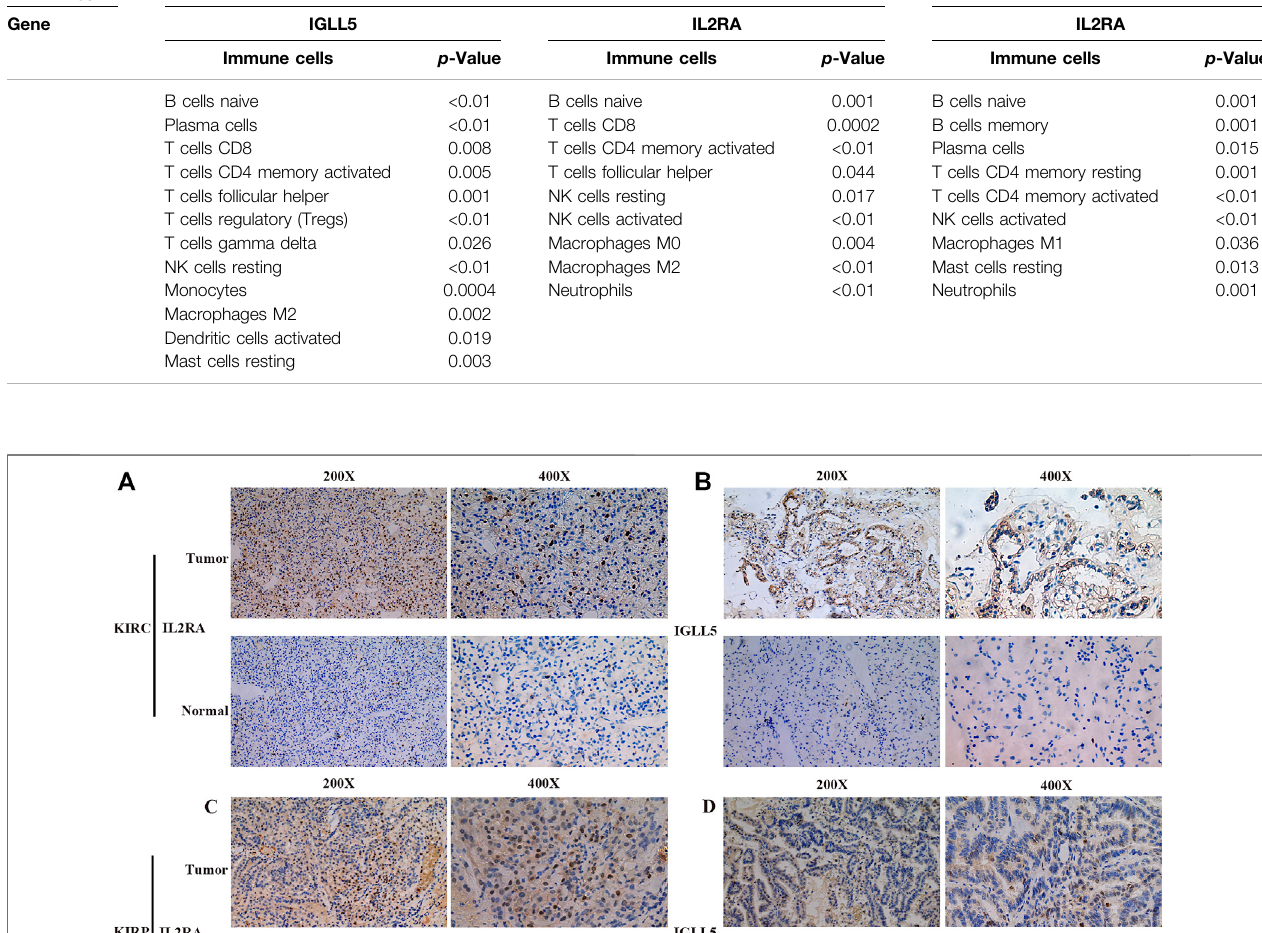
Frontiers in Molecular Biosciences |